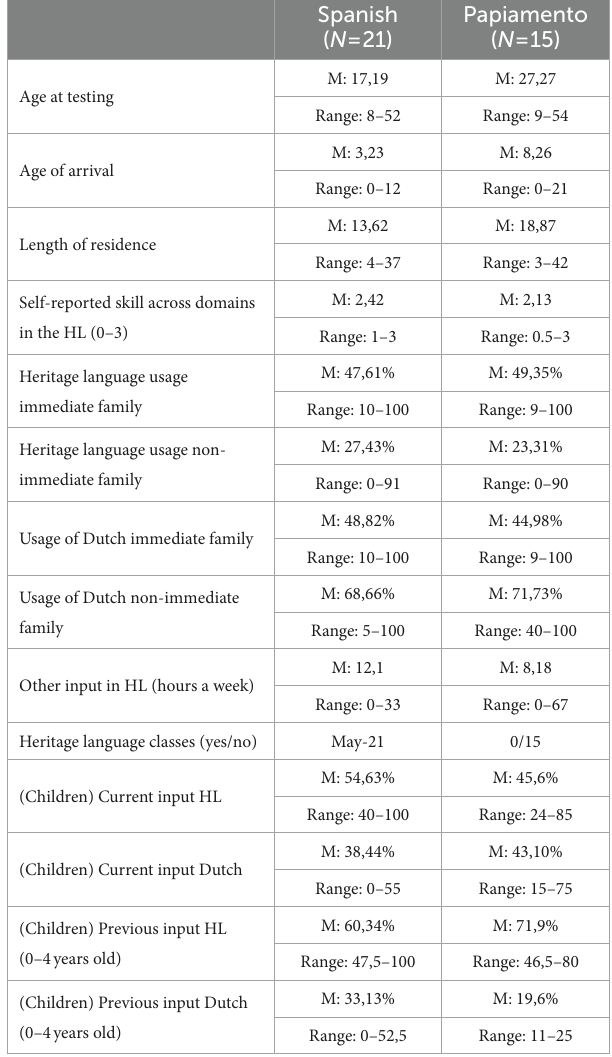
TABLE 1 Socio-linguistic information about the